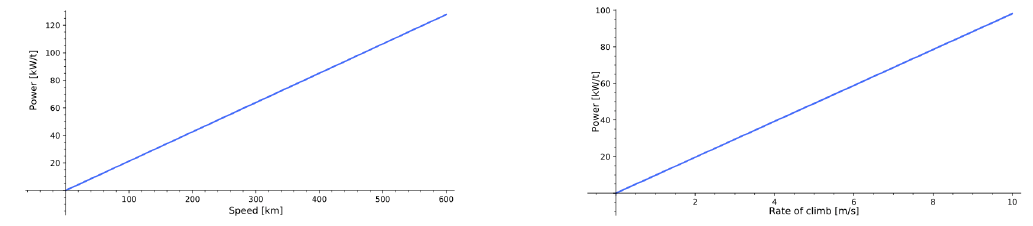
Figure 2. Battery power per tonne of aircraft mass required by an aircraft; ( left ) to maintain a certain speed; and ( right ) to achieve a specific rate of